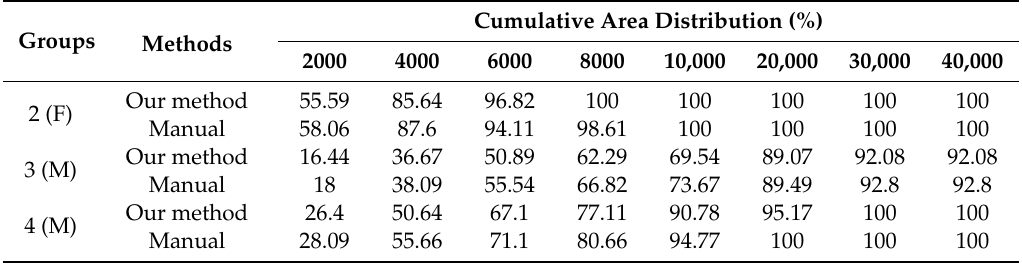
Table 3. The results of mixed material images from groups 2 to 4, processed by our method.